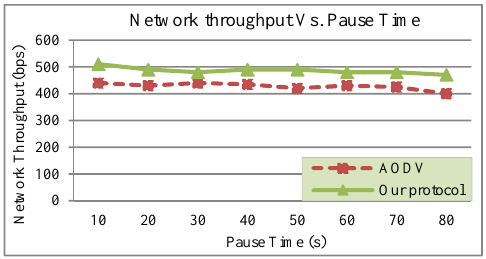
Fig. 9. Network Throughput Vs. Pause